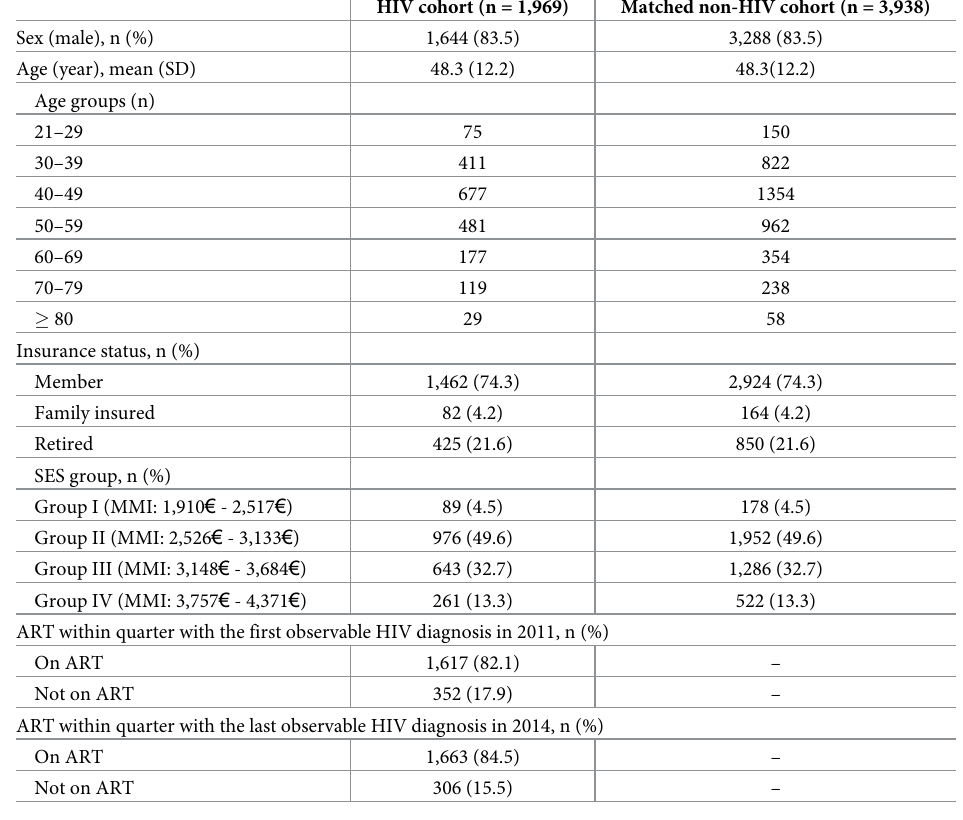
Table 1. Sociodemographic characteristics and HIV treatment in PLHIV and a matched non-HIV cohort. HIV cohort (n = 1,969) Matched non-HIV cohort (n = 3,938) Sex (male), n (%) 1,644 (83.5) 3,288